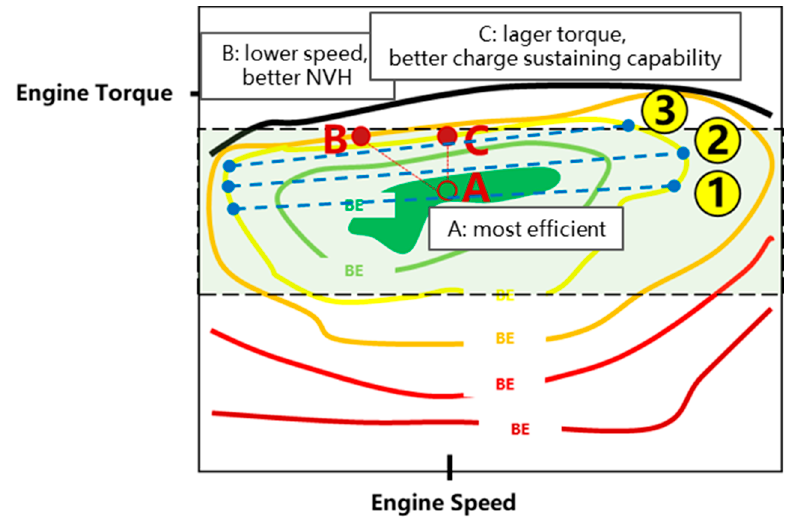
Figure 4. Basic strategy logic of DMi energy management.